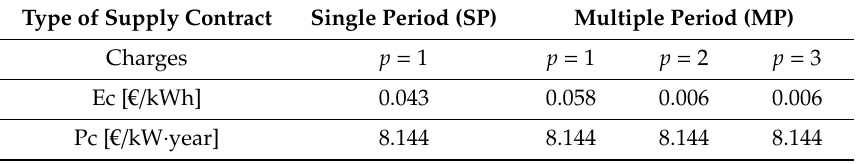
Table 3. Self-consumption charges